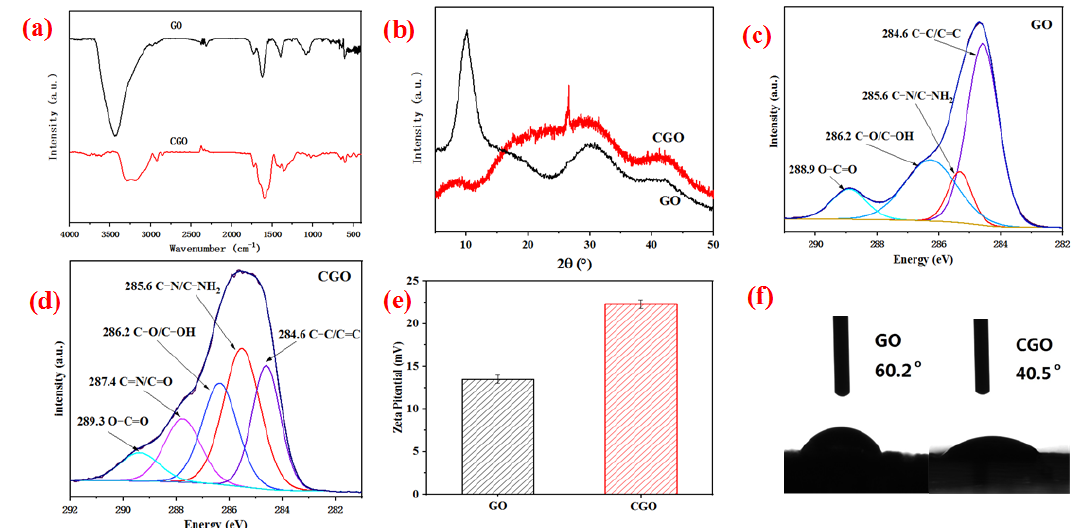
Figure 2. ( a ) FTIR of GO and CGO, ( b ) XRD patterns of GO and CGO, ( c )XPS spectra of GO, ( d ) XPS spectra of CGO, ( e ) zeta potential and ( f ) water contact angle of GO and CGO.